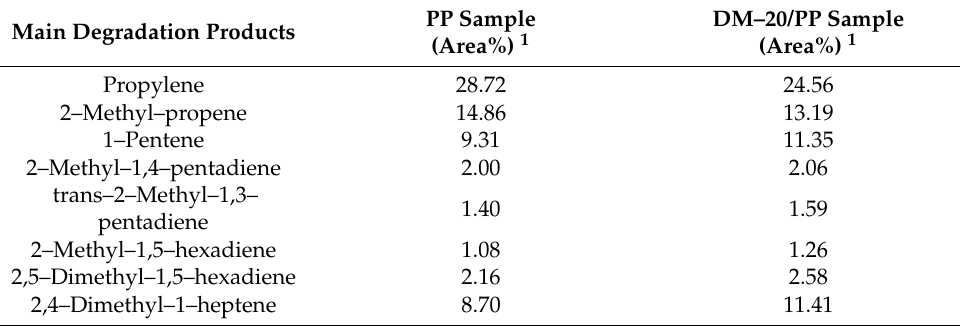
Table 1. The content of main degradation products of pure PP and DM–20/PP. Main Degradation